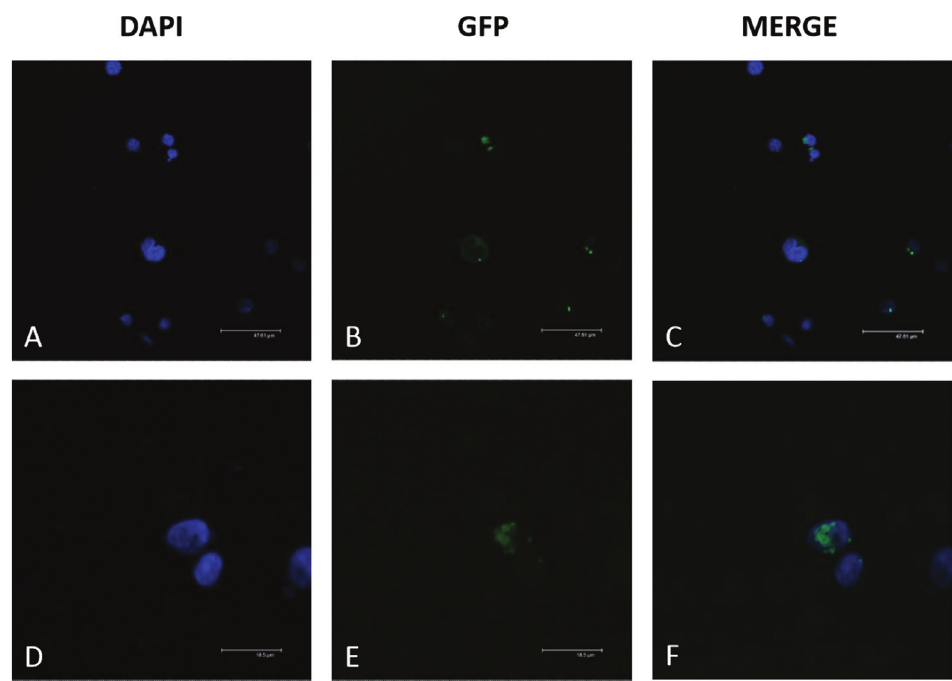
Figure 4 - Localization of recombinant MEFV proteins in untreated HL-60 cells. MEFV -fl-GFP and MEFV -d2-GFP constructs were transfected via Nucleofection and the localization of their products was analyzed using confocal microscopy. The transfection efficiency was 67% for MEFV -fl and 58% for MEFV -2d. A) DAPI staining of HL-60 cells transfected with MEFV -fl-GFP; B) GFP visualization of MEFV -fl-GFP; C) Merged image of A and B; D) DAPI staining of HL-60 cell transfected with MEFV -d2-GFP; E) GFP visualization of MEFV -d2-GFP; F) Merged image of D and E.